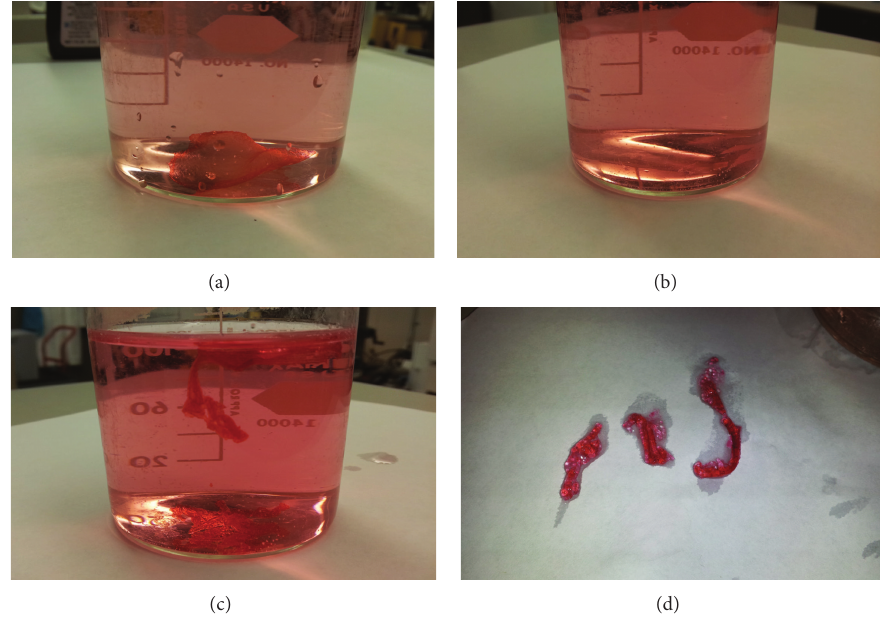
Figure 3: Irradiated samples were compared with samples without irradiation for temperature stability. These samples were prepared using the protocols described. Both samples were stained with red food dye and placed in an 85 ∘ C water bath. (a) Sample without irradiation before heating. (b) Sample without irradiation after heating. (c) Irradiated sample before heating. (d) Irradiated sample removed from water and shown after heating.